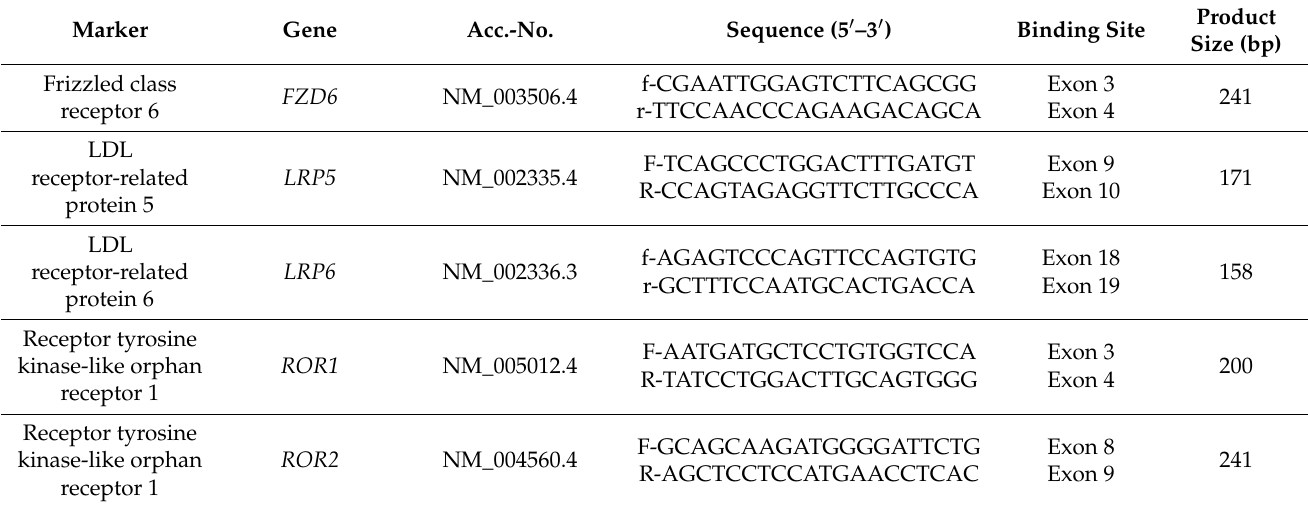
Table 1. List of primers for the detection of Wnt (co-)receptors by qRT-PCR. Acc.-No., Accession number; bp, base pairs. Marker Gene